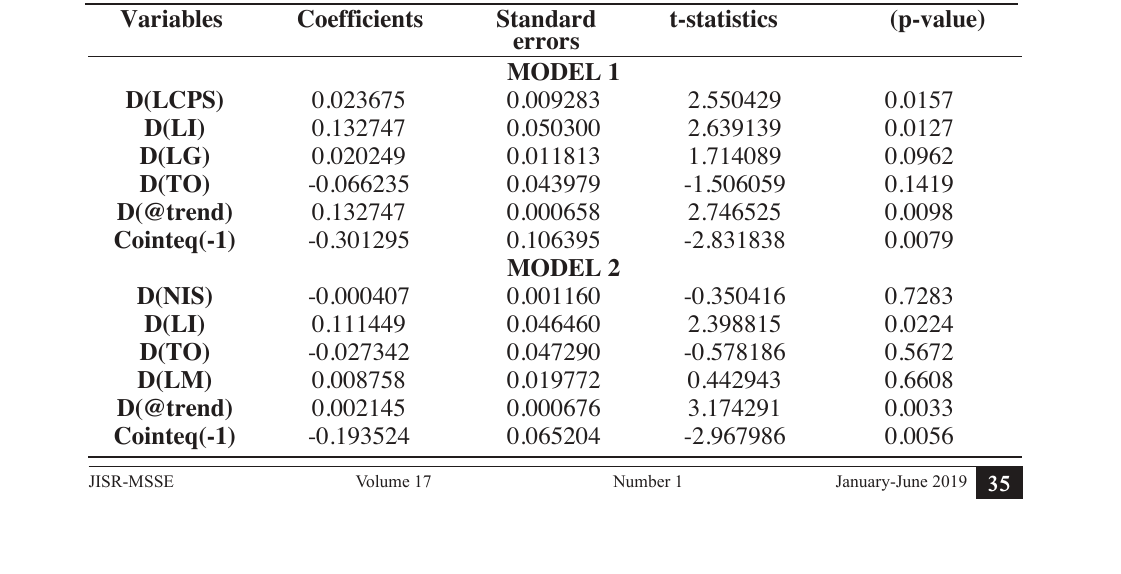
Table 6: Shor t-run results of model 1and